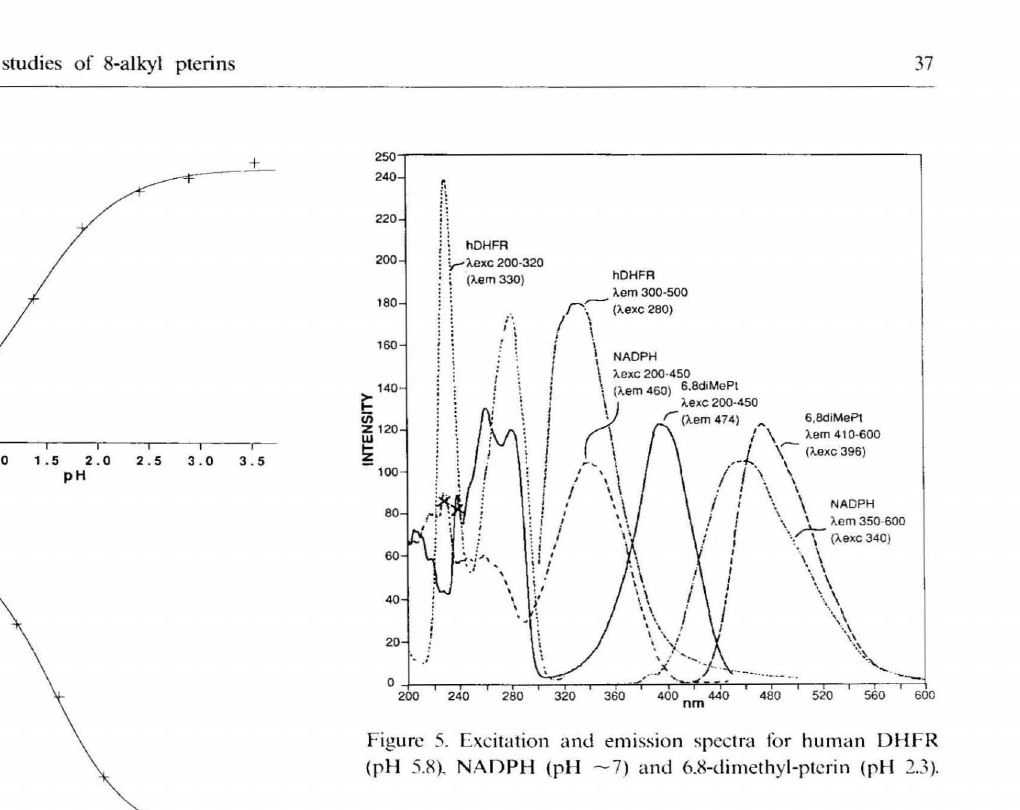
Figure 5. Excitation and emission spectra for human DHFR (pH 5.X), NAOPH (pH ~ 7) and 6,X-dimethyl-ptcrin (pH